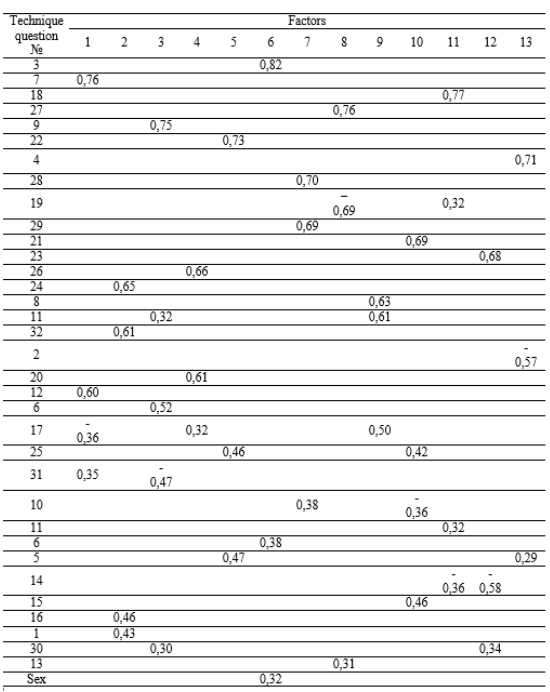
Table 1. Factor loadings of technique